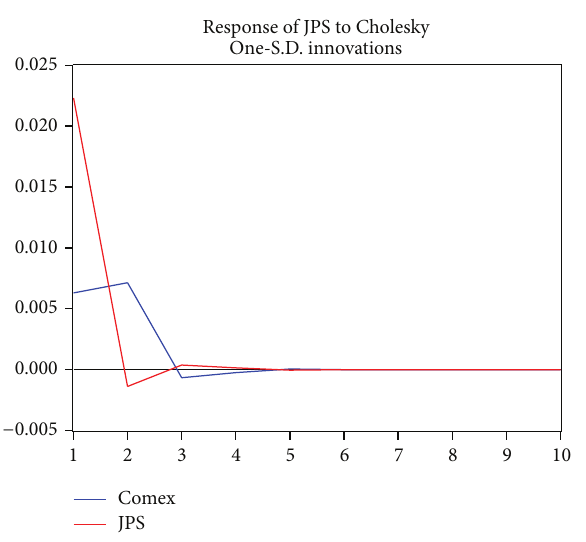
Figure 2: The impulse response function analysis graph of